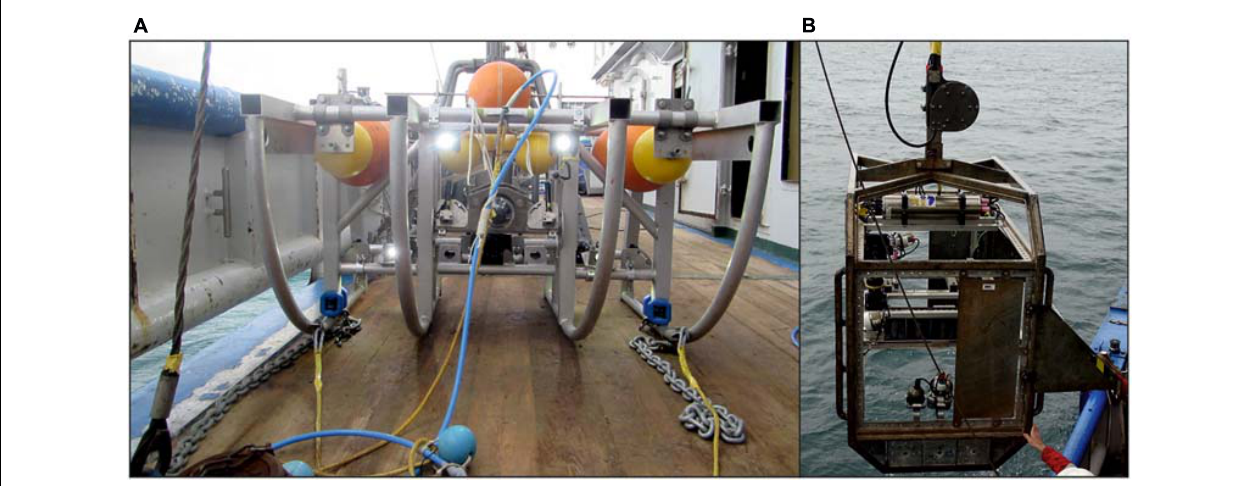
FIGURE 2 | The different camera frames used in this study, showing the towed video frame (A) and the drop camera (B) . Note the differences in towing construction and camera set-up. The towed video frame (A) has three (yellow) towing cables on the front of the frame, and a forward-facing camera. For the drop camera (B) , the towing cable is attached to the top of the frame, and has a downward-facing camera. Photo credits to Danielle Prins-de Jonge (A) and Jip Vrooman (B) .